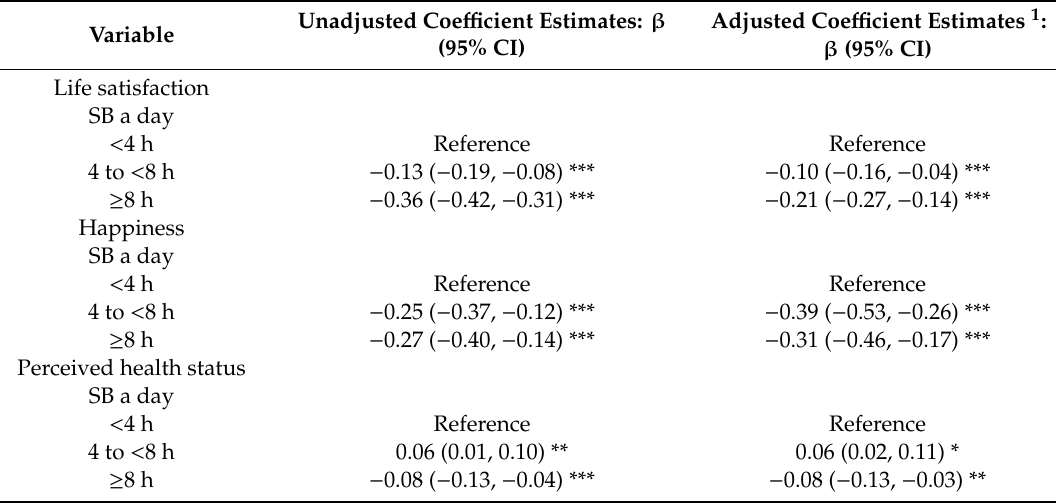
Table 2. Coe ffi cient estimates for life satisfaction, happiness and perceived health